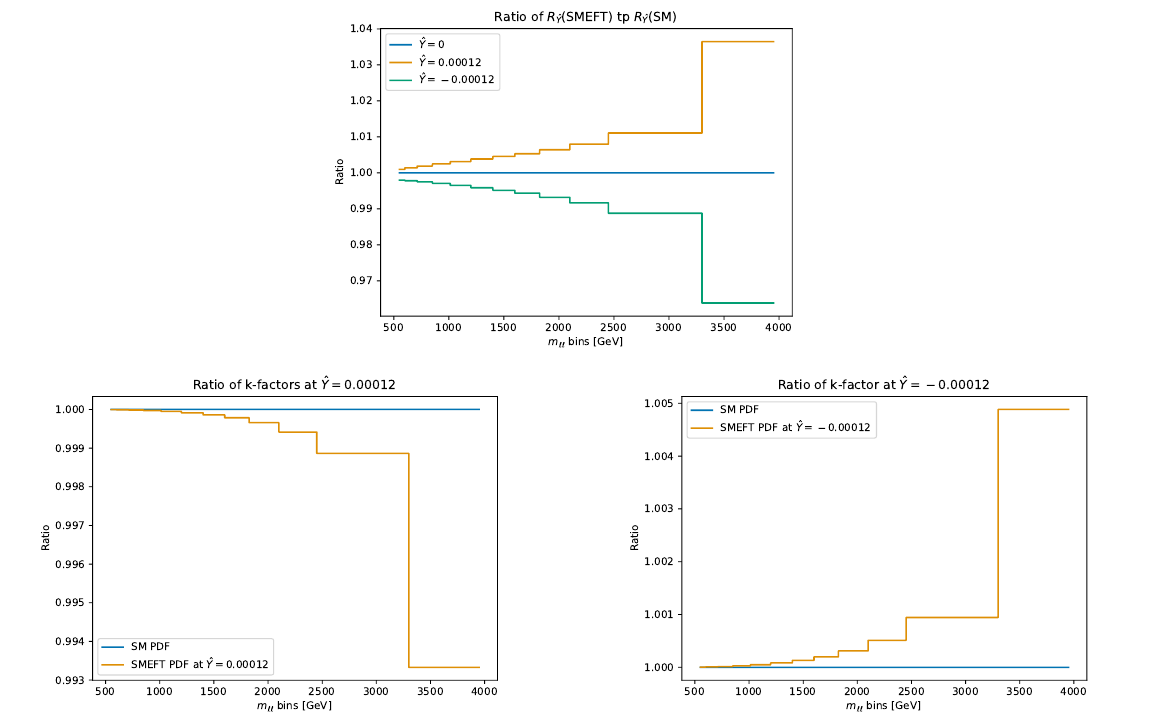
Figure 29 . Same as figure 28, in the case of ˆ Y